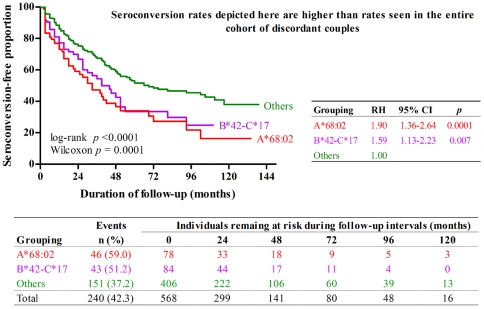
Kaplan-Meier plots for HIV-1 acquisition among 568 Zambian initial HESNs stratified by HLA-A*68:02 and B*42-C*17.Of the 11 individuals with both A*68:02 and B*42-C*17, five acquired HIV-1 at rates similar to those in carriers of B*42-C*17 alone; these 11 were treated as part of the B*42-C*17 group. Differences in acquisition-free time among the three HLA subgroups were tested for significance by the log-rank and Wilcoxon methods. Estimates of relative hazards (RH) of HIV-1 acquisition are based on Cox proportional hazards models. The numbers of subjects remaining at-risk at successive follow-up intervals are tabulated below the Kaplan-Meier plots. The seroconversion rate does not reflect the overall rate in the entire ZEHRP cohort, because couples in this study were selected for clinical and behavioral HIV-1 risk characteristics.